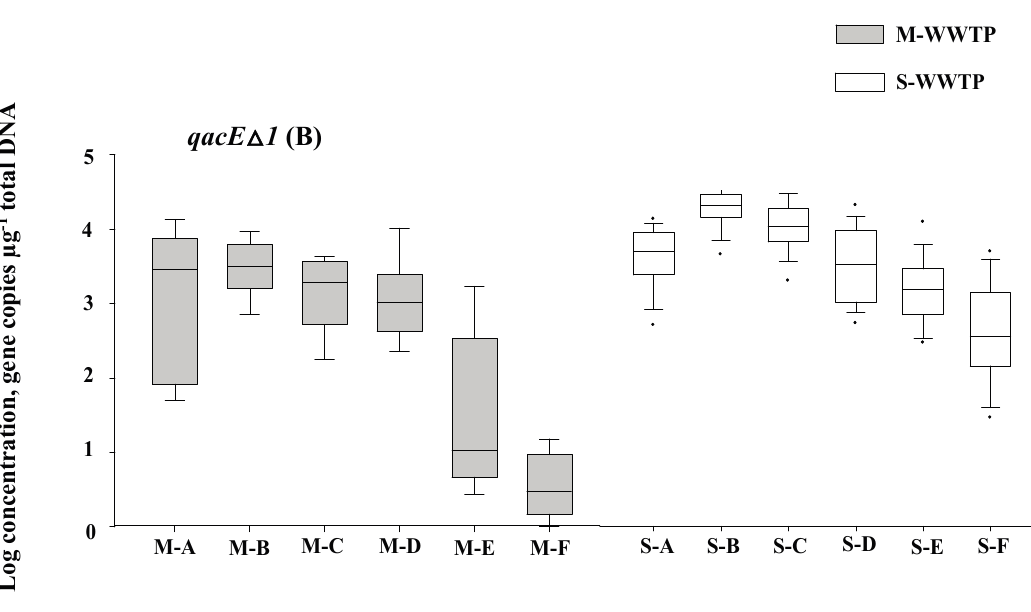
Figure 2. Abundance of intI1 (A) and qacE Δ 1 (B) determined with the SYBR Green real-time qPCR. M-WWTP: municipal wastewater treatment plant.